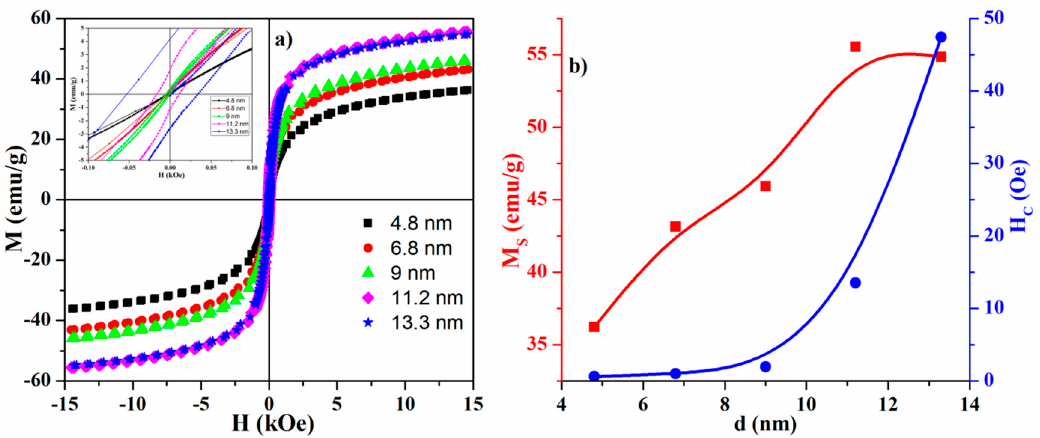
Figure 3. ( a ) Magnetic hysteresis loops of the magnetite nanoparticles; ( b ) size dependence of saturation magnetization and coercivity. The inset shows the hysteresis loops in an enlarged scale.